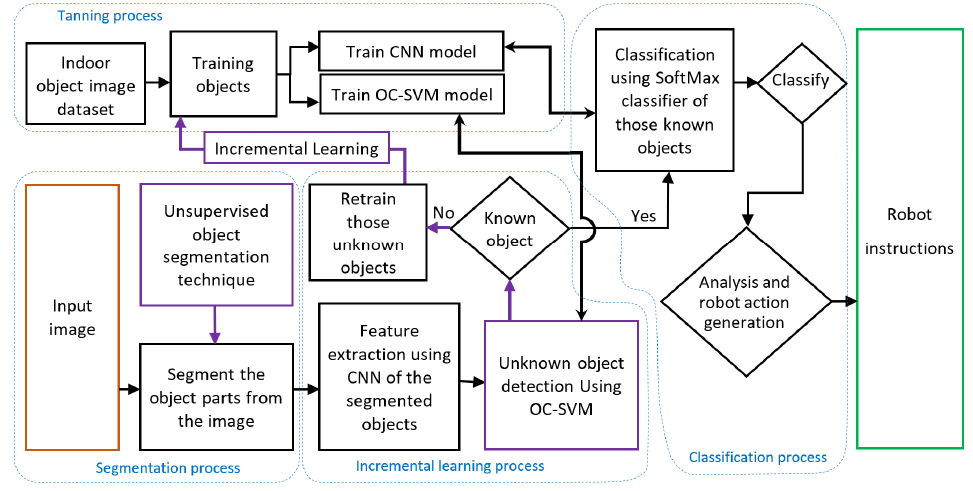
Figure 3. Robot data analysis process in the cloud-based station.